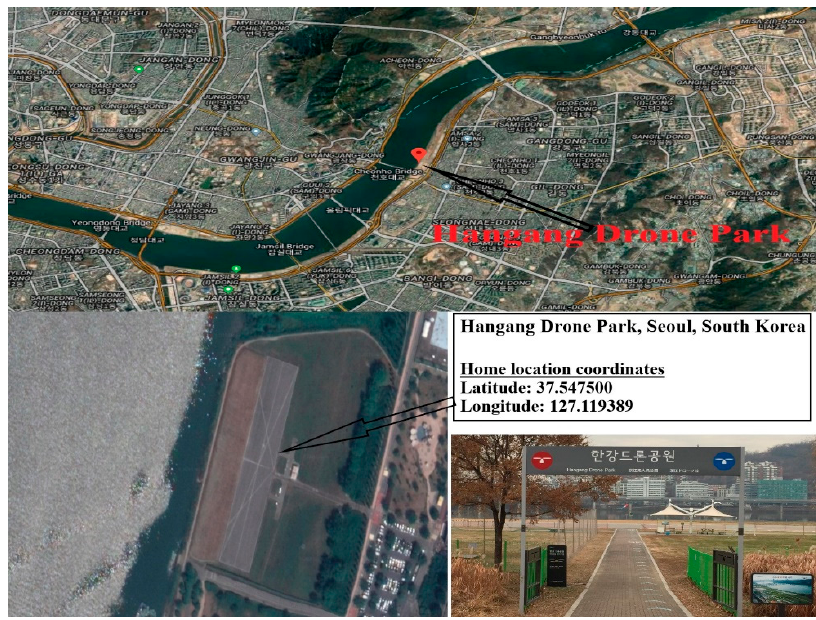
Figure 4. Airfield location (Hangang Drone Park) in Seoul, South Korea.